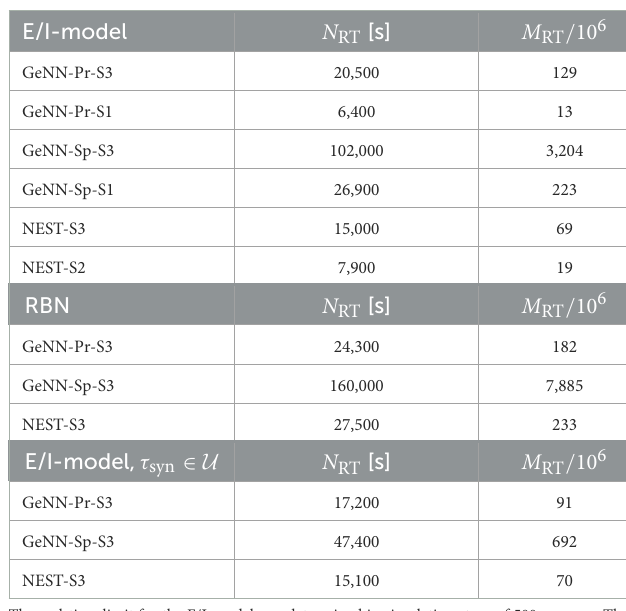
TABLE 2 Maximum network size N RT within real-time